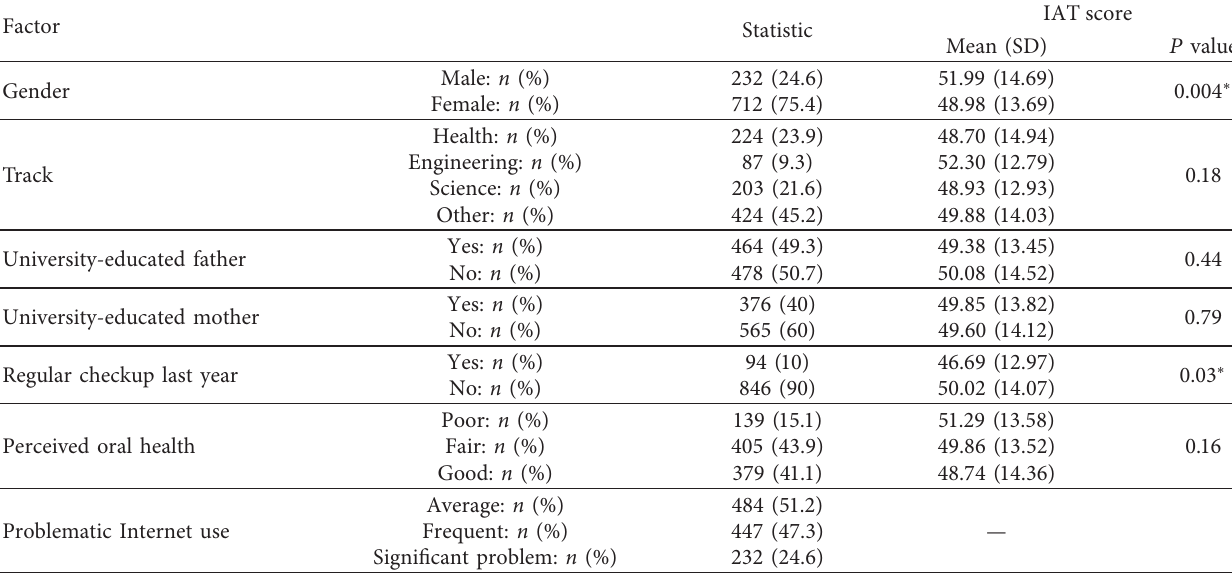
Table 1: Personal, socioeconomic, and dental characteristics of